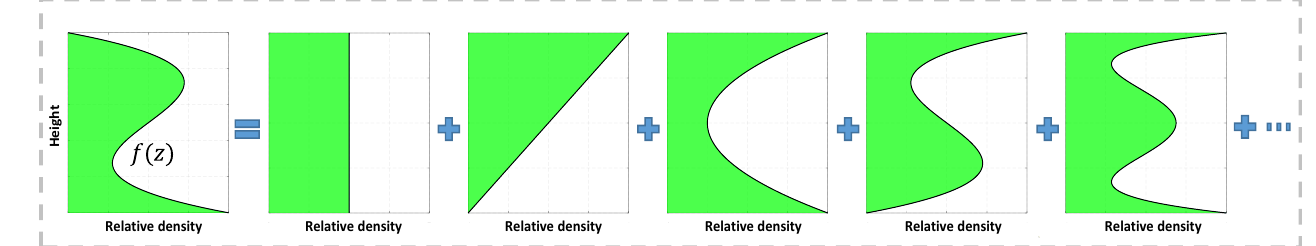
Figure 2. PCT vertical structure function reconstruction. The right side of the equal sign is a set of standard Legendre functions, which can be combined with the coefficient a n 0 to construct the forest vertical scattering function (left side of the equal sign).